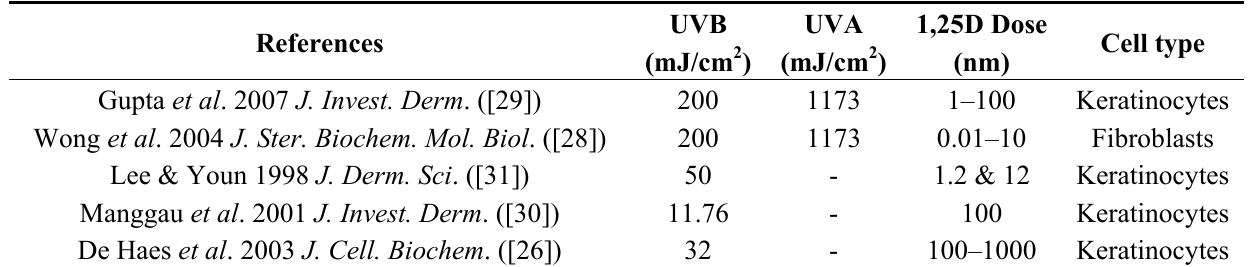
Table 1. Analysis of various studies of protection against UV-induced cell death by 1,25D, taking into account the UV output, dose of 1,25D and skin cell type.